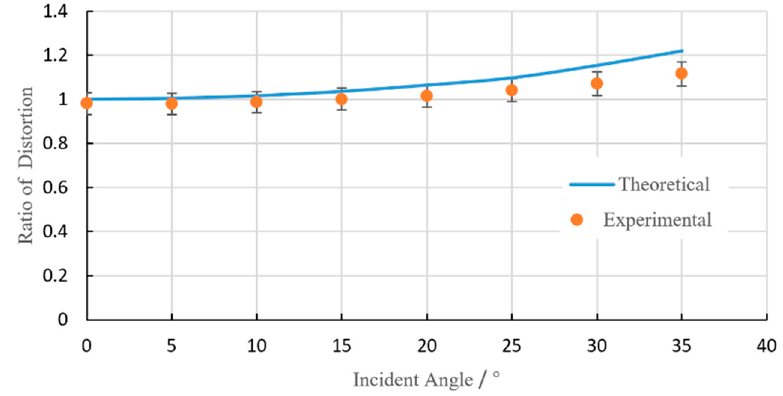
Figure 7. A comparison of etching distortion between the theory and the experiment.